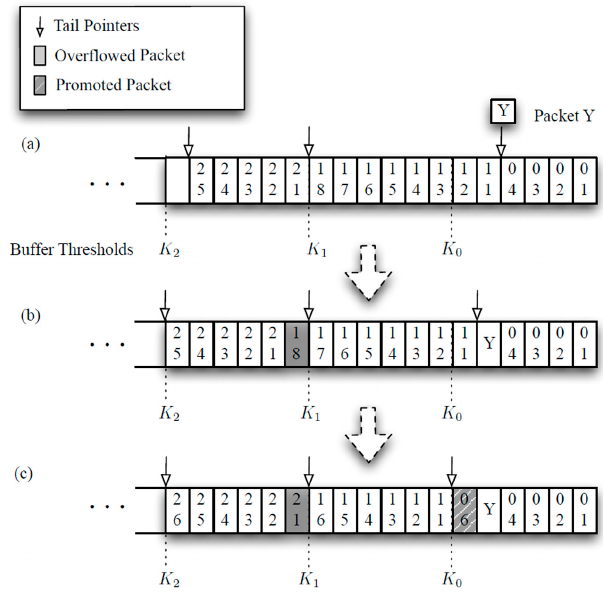
Figure 5. Second scenario of a packet overflow. K 0 = 6, K 1 = 12, K 2 = 18.